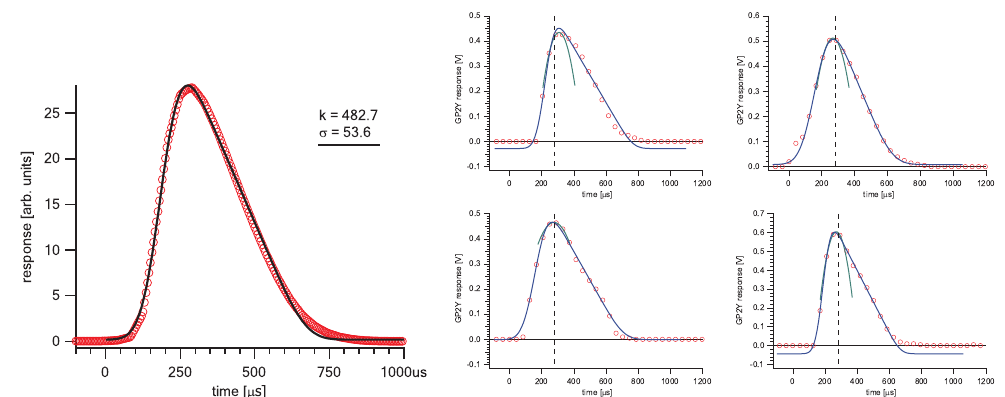
Figure 5. ( Left ) model function from Equation (3) with k = 482.7, σ = 53.6 (black solid) compared to a measured average pulse shape (red circles). ( Right ) some randomly chosen examples of individual real pulses successfully fitted with the model function (blue line, Equation (3)) and parabola through highest three points (green). The dashed vertical line corresponds to the manufacturer’s recommended sampling